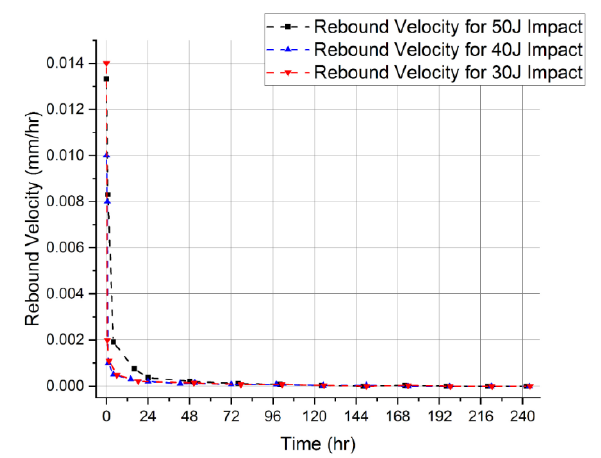
Figure 8. Rebound velocity vs. time graph.